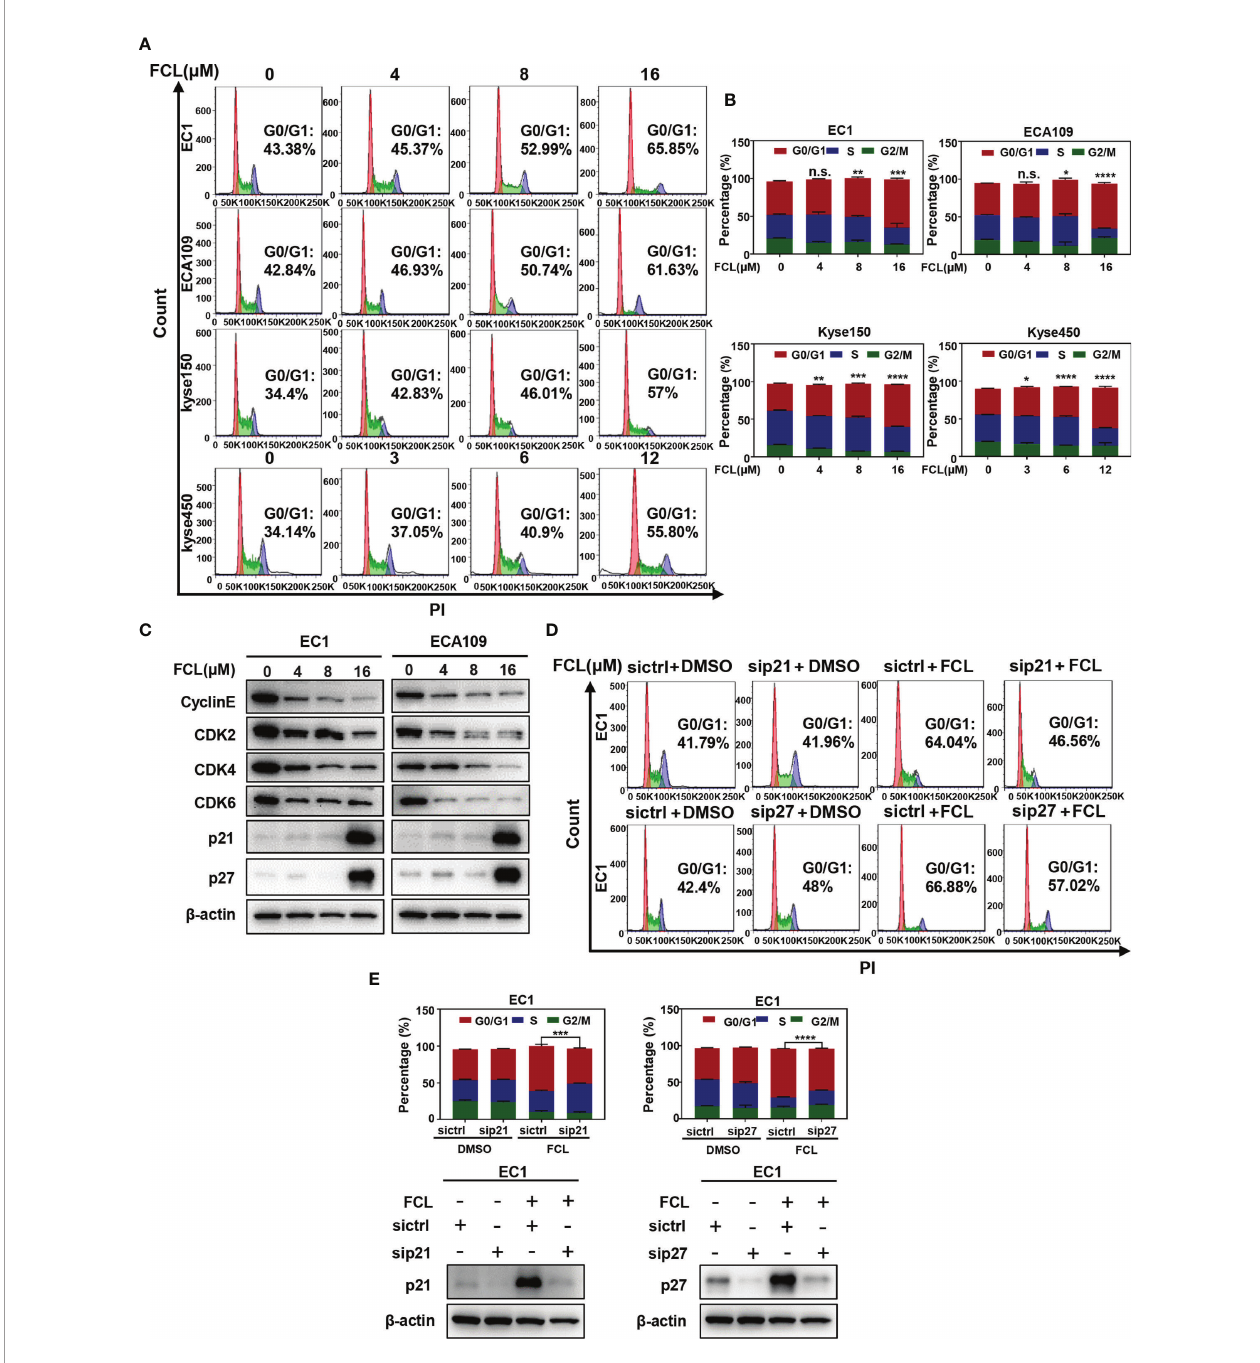
FIGURE 2 | Fangchinoline arrested ESCC cells in G1 phase. (A, B) ESCC cells were pre-incubated with DMSO or FCL for 24 hours, followed by PI staining and FACS analysis for cell ‐ cycle pro fi ling. (C) FCL ‐ induced decrease of CyclinE, CDK2, CDK4, CDK6 was accompanied by the accumulation in p21 and p27. After 24 hours of FCL treatment at the indicated concentrations, EC1 and ECA109 cells were subjected to Western blotting using antibodies against Cyclin E, CDK2, CDK4, CDK6, p21 and p27 with b -actin as a loading control. (D) EC1 and ECA109 cells were transfected with control or p21 or p27 siRNA (72 hours), treated with 16 m mol/L FCL (24 hours), and subjected to PI staining and FACS analysis. (E) The percentage of cells at the G0/G1 phase was indicated. The protein levels of p21 or p27 were determined by Western blotting analysis with b -actin as a loading control. *denotes P < 0.05, **denotes P < 0.01, ***denotes P < 0.001, ****denotes P < 0.0001, n.s. denotes not signi fi